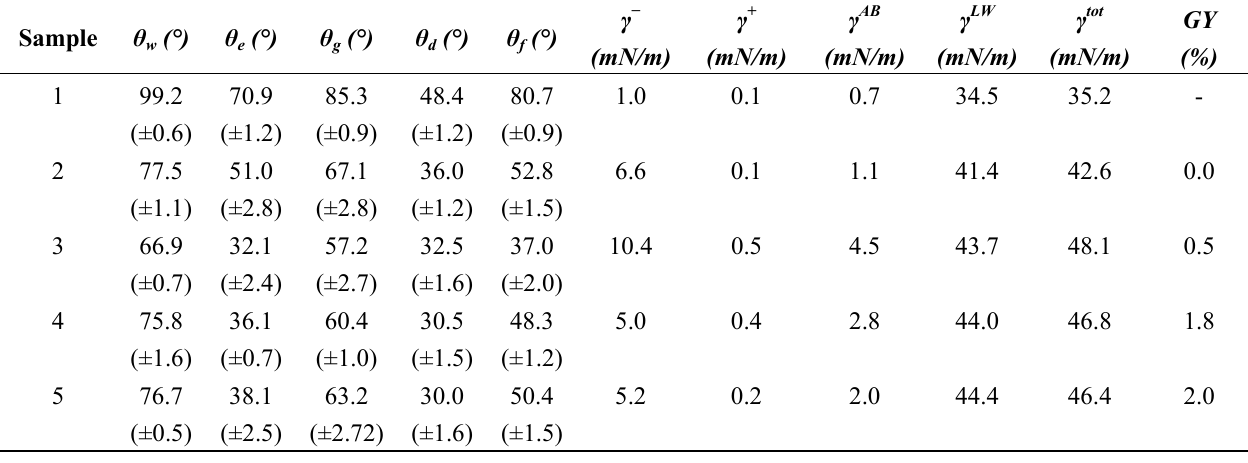
Table 1. Surface properties of LDPE treated by multistep process.